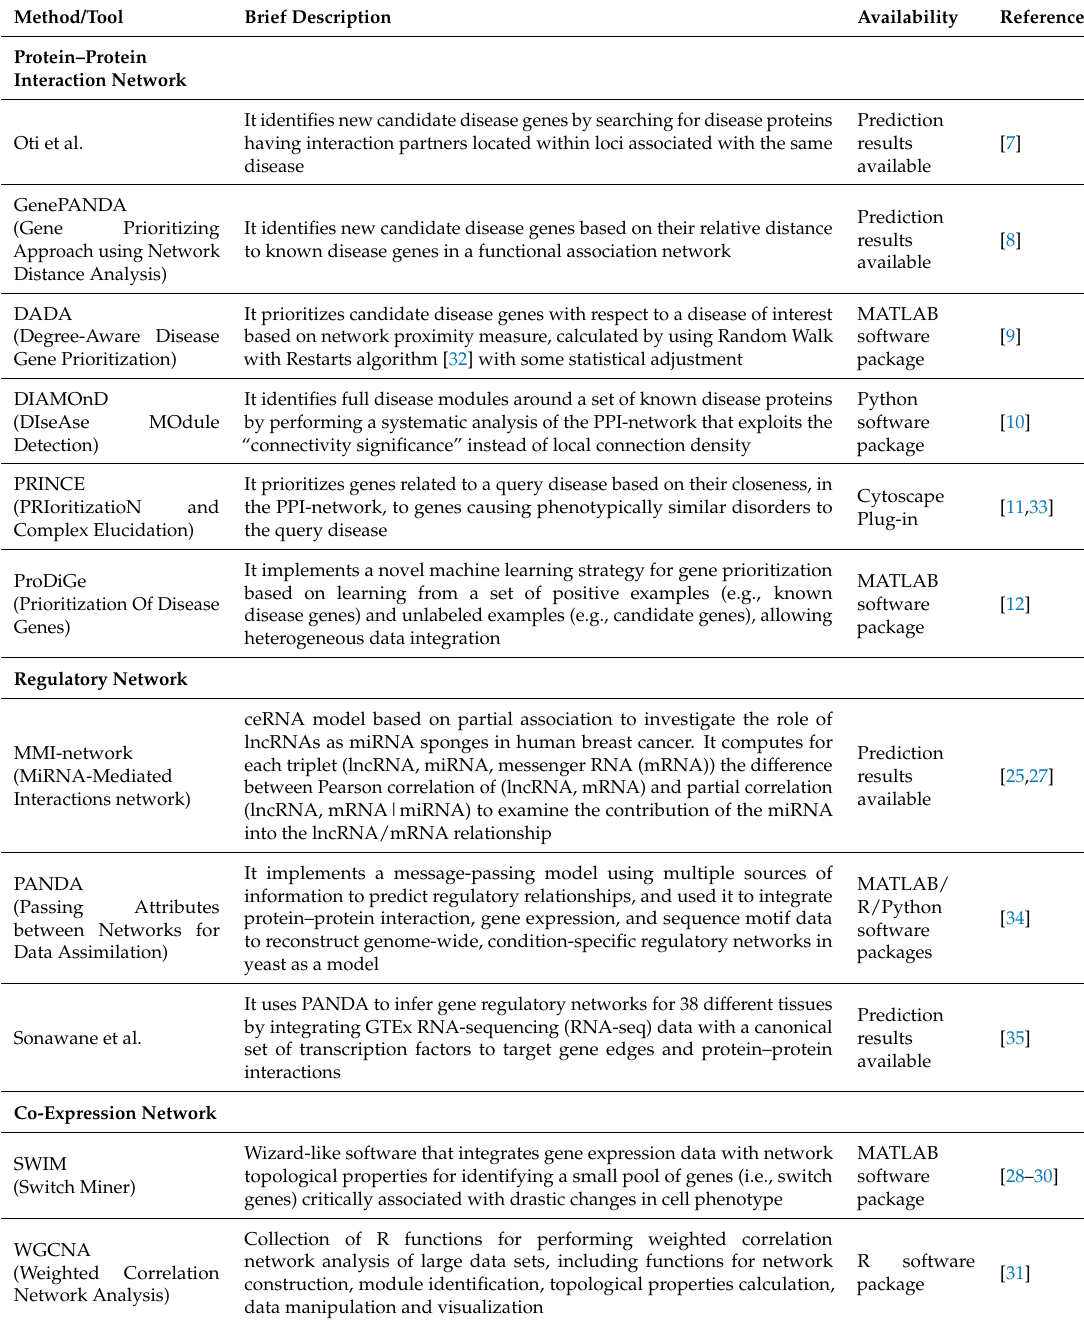
Table 1. Overview of network-based approaches to